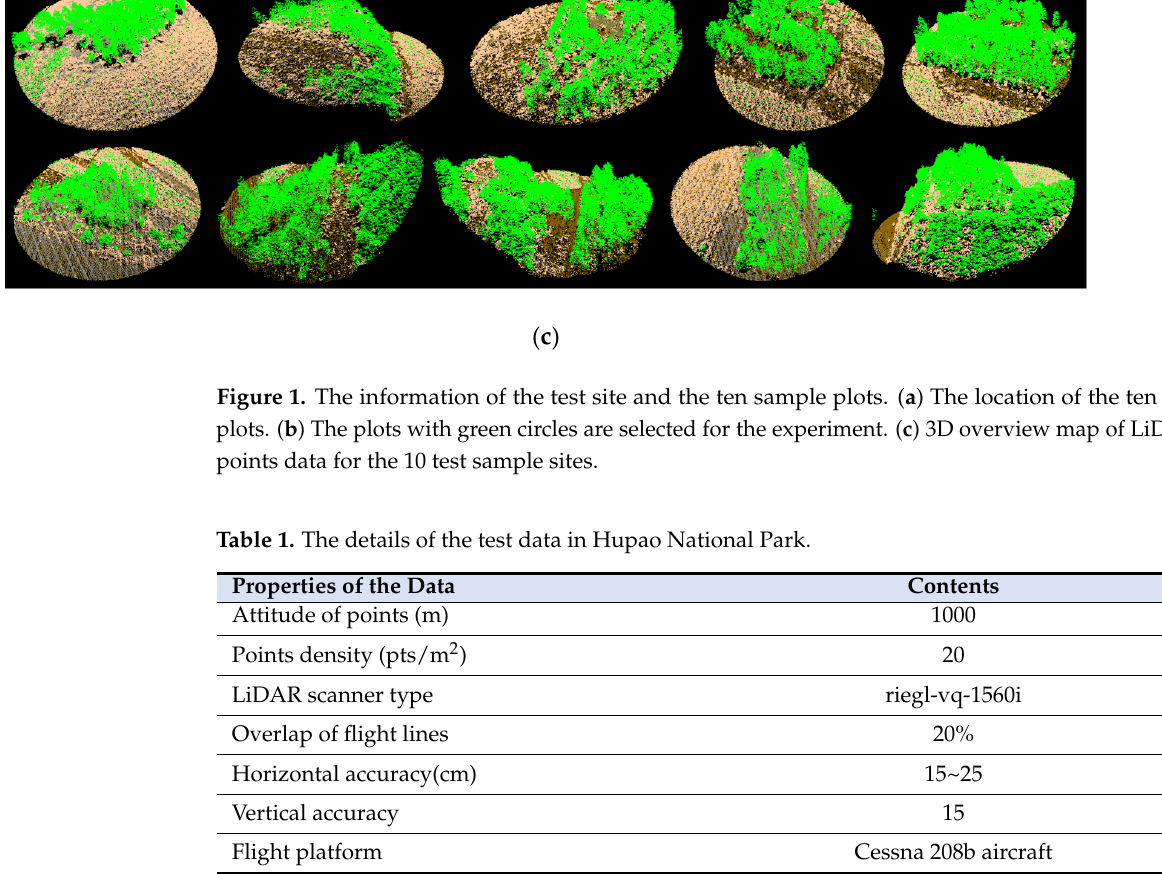
Table 1. The details of the test data in Hupao National Park.